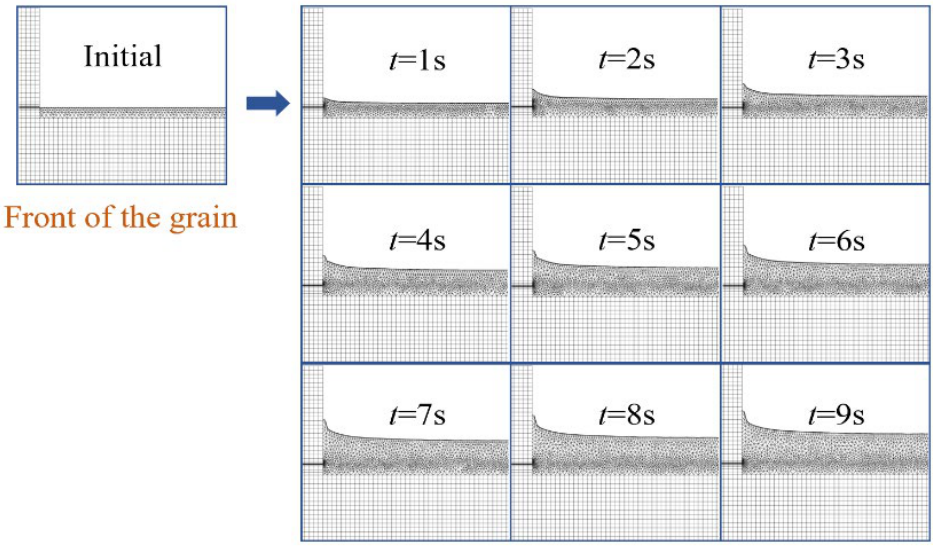
Figure 9. Mesh of the pre-chamber and the front of grain.